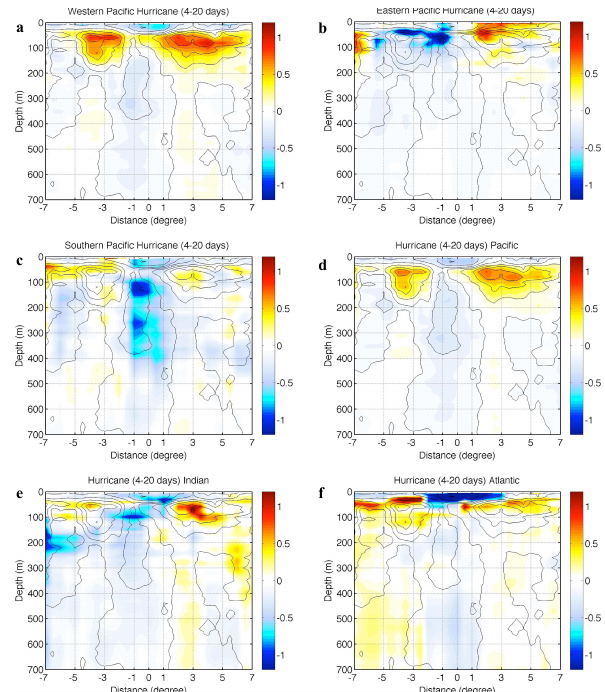
Figure 15. Ocean thermal changes induced by hurricanes within 4–20 days after storm passage for individual ocean basins: (a) in the western Pacific Ocean, (b) in the eastern Pacific Ocean, (c) in the southern Pacific Ocean, (d) in the Pacific Ocean, (e) in the In- dian Ocean, and (f) in the Atlantic Ocean. The black contours are the global-averaged hurricane-induced ocean thermal changes in 4– 20 days, which are the same as those in Fig. 10c. The unit is ◦